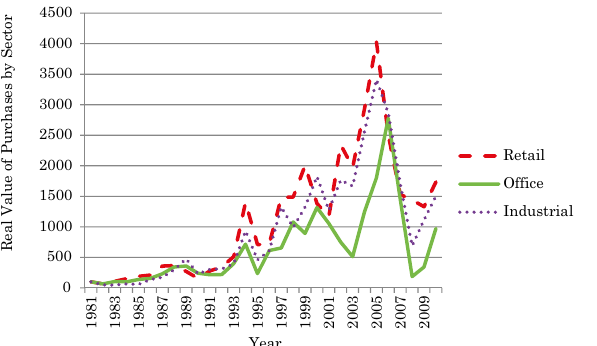
fig. 6. Trends in the real value of sales based on HP filter ( λ =